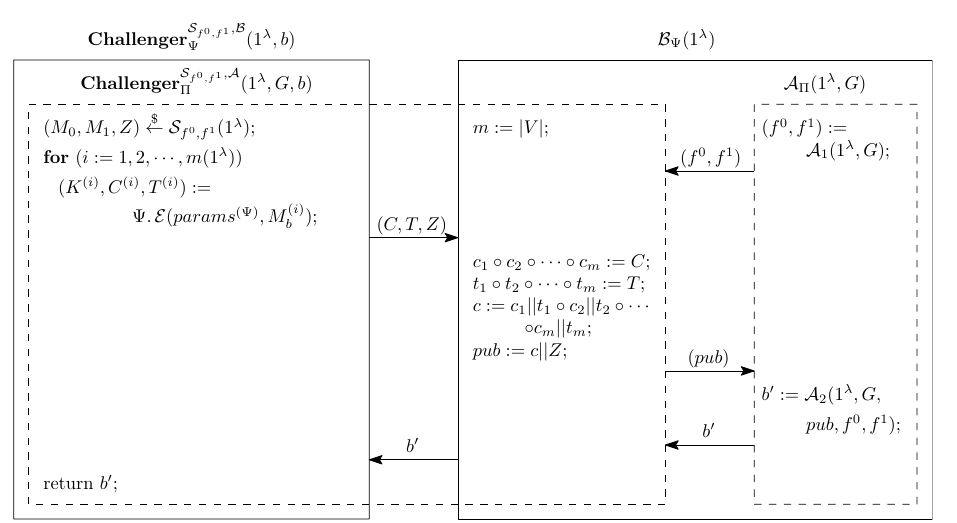
Figure 12: The reduction used in Theorem 6: MLE adversary is constructed using KAS-AE-chain adversary.